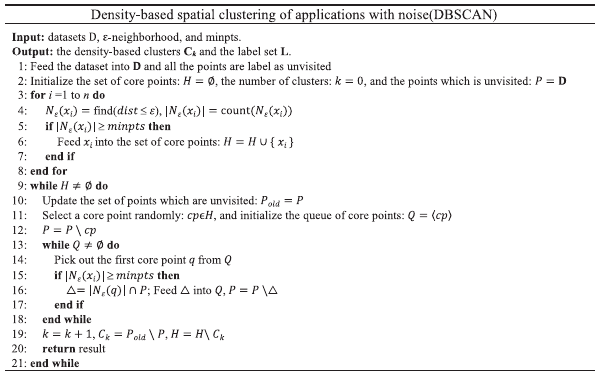
Algorithm 1. : Density-based spatial clustering of applications with noise(DBSCAN).